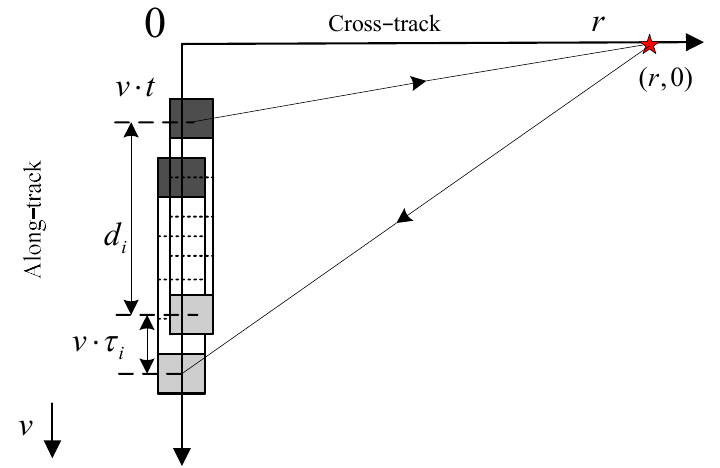
Figure 1. Imaging geometry of the multi-receiver SAS.